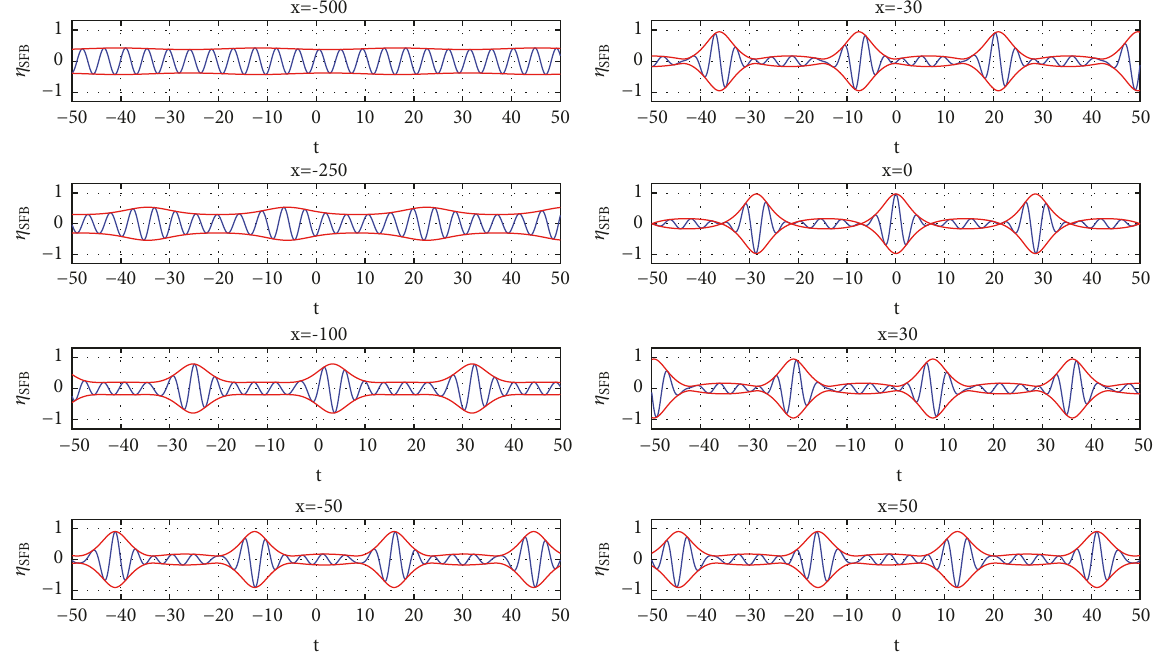
;̃𝑘;̂ ] ) = (0.2;0.9186; 1) 0